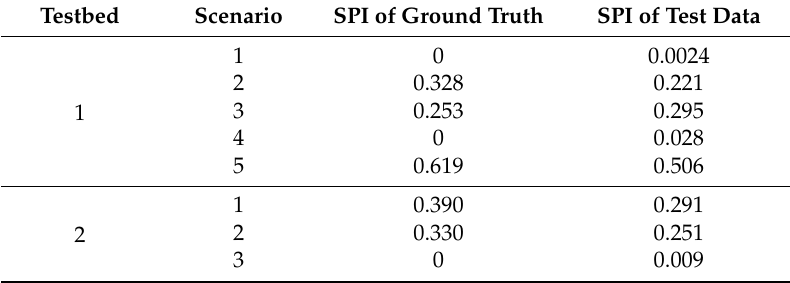
Table 1. Comparison of the Aggregated Safety Performance Index for ground truth and test data.